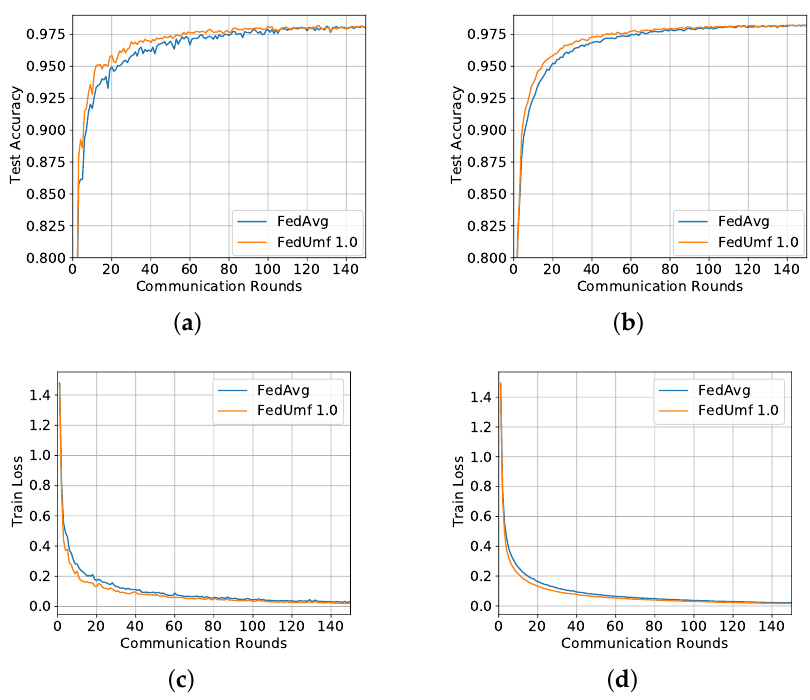
Figure 6. Server test accuracy, and client-side training loss curve performance, non-IID partition and η = 0.05 on MNIST. ( a ) Test accuracy. C = 0.1. ( b ) Test accuracy. C = 0.5. ( c ) Training loss. C = 0.1. ( d ) Training loss. C =